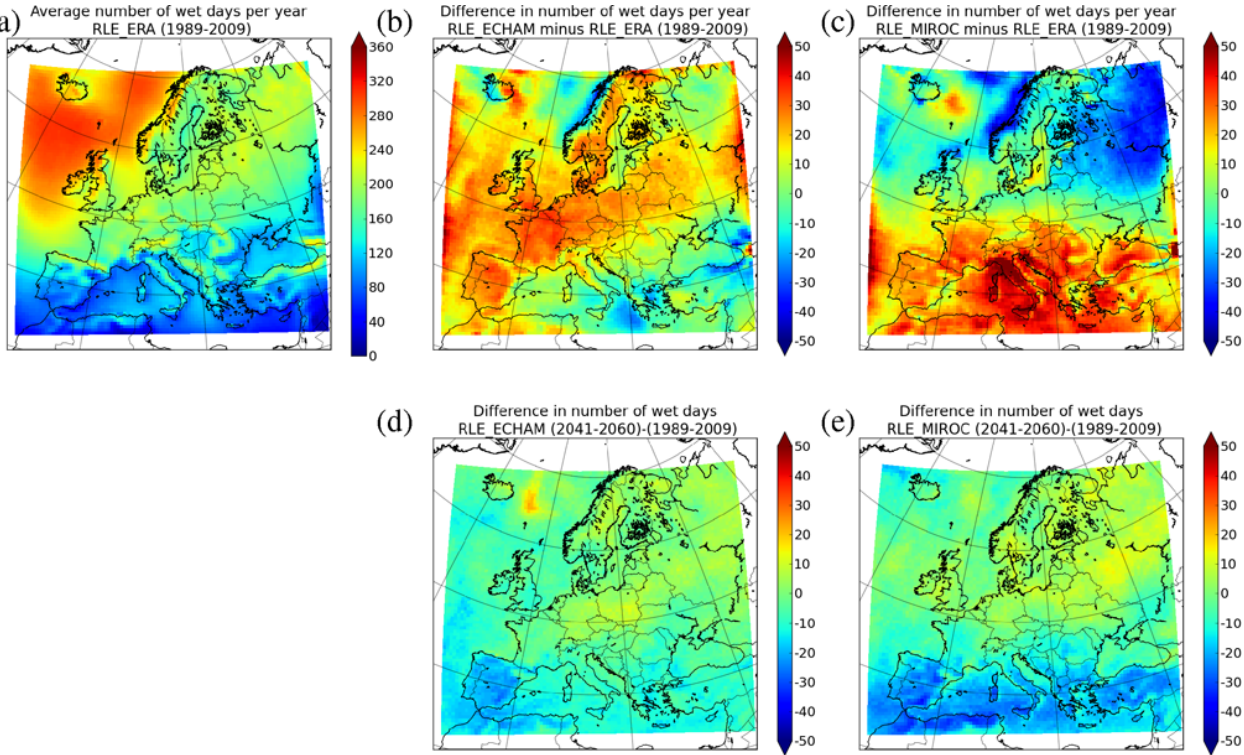
Fig. 5. Like Fig. 3, but showing the average number of wet days.